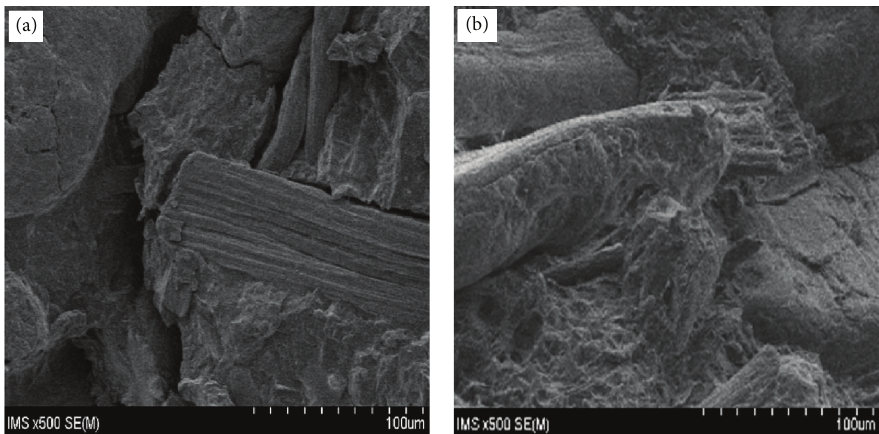
Figure 23: SEM micrographs of (a) PP/RHF and (b) PP/RHF with 4wt% of MAPP